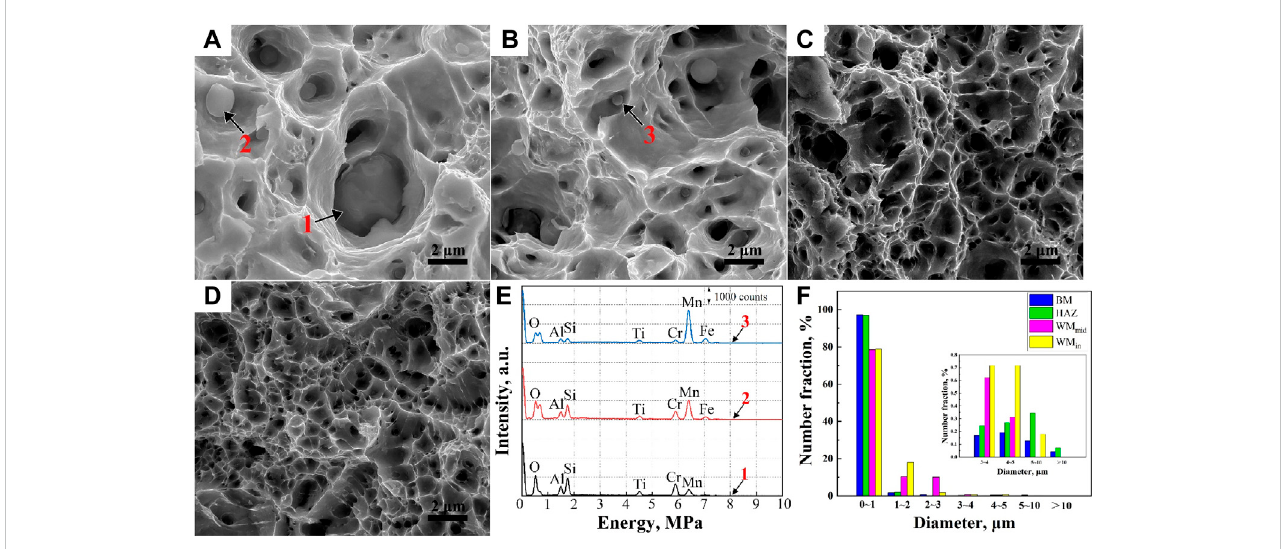
FIGURE 10 Fracture morphologies of the WM in (A) , WM mid (B) , HAZ (C) , and BM (D) . The corresponding EDS maps (E) of inclusions are marked by 1, 2, and 3, respectively. The number fraction of the dimples ’ diameter in a certain diameter is shown in (F) .